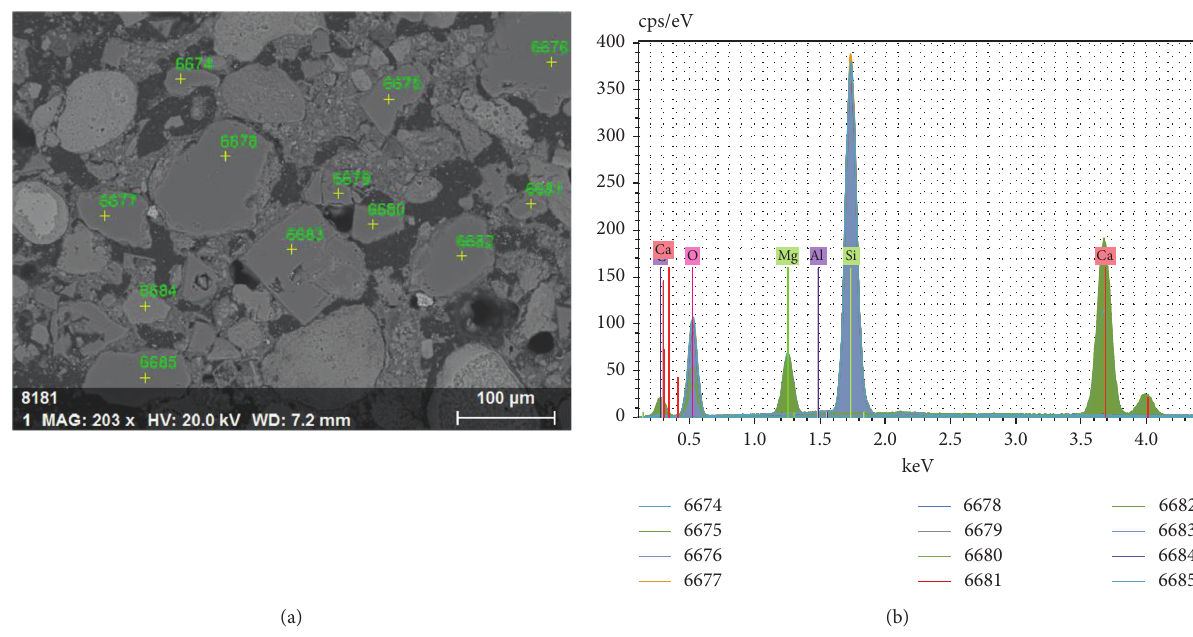
Figure 10: Backscattered electron diagram and energy spectrum of